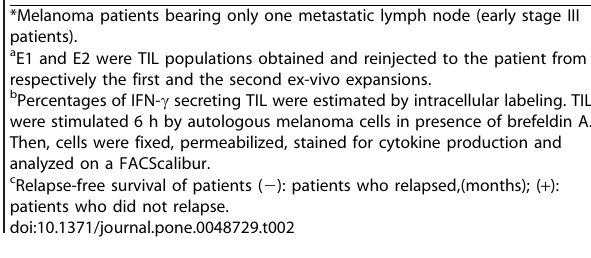
Table 2. Fractions of tumor-reactive lymphocytes in large- scale expanded TIL from melanoma-invaded lymph nodes of 47 patients treated by TIL.